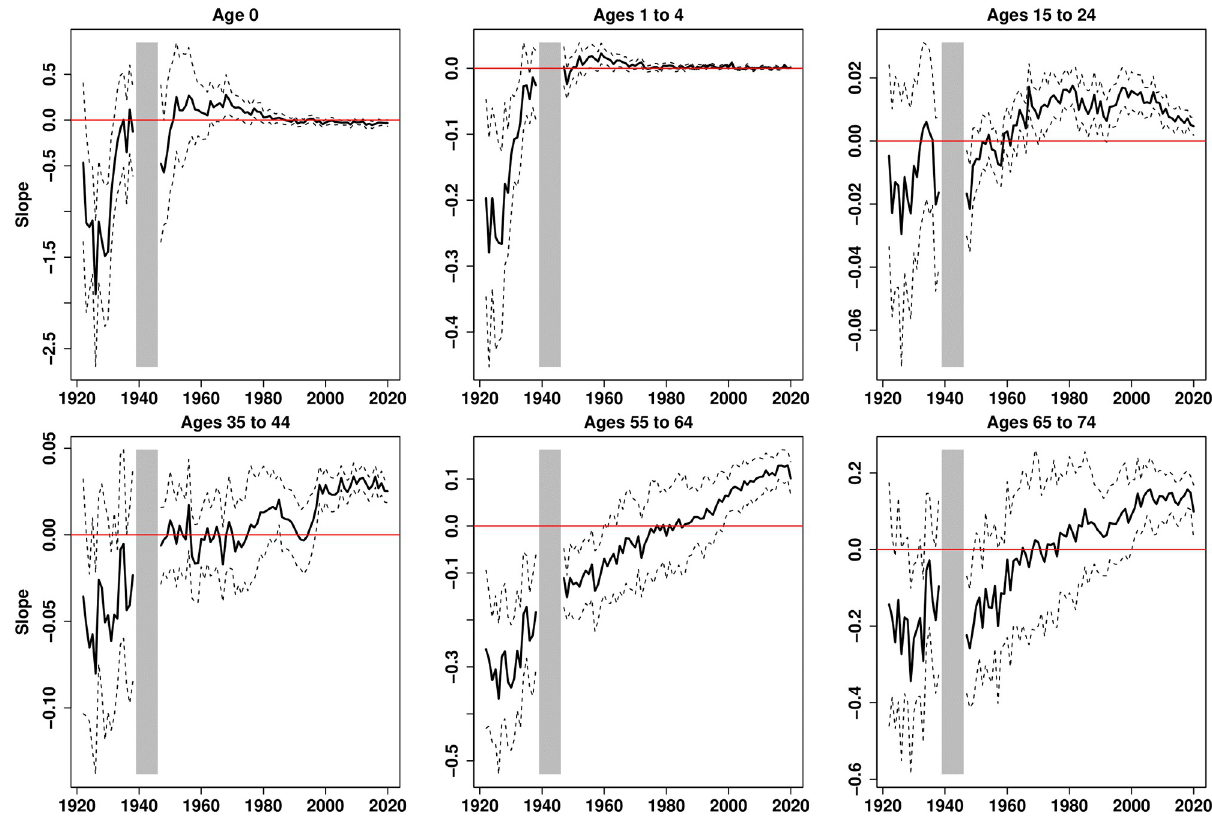
Fig 2. Income gradient in mortality for 6 age groups, 1922–2020. Plain curves plot the estimates of the linear trends across income groups; dotted lines are the 95% confidence intervals. Gradients are not represented for the period 1939–1945.